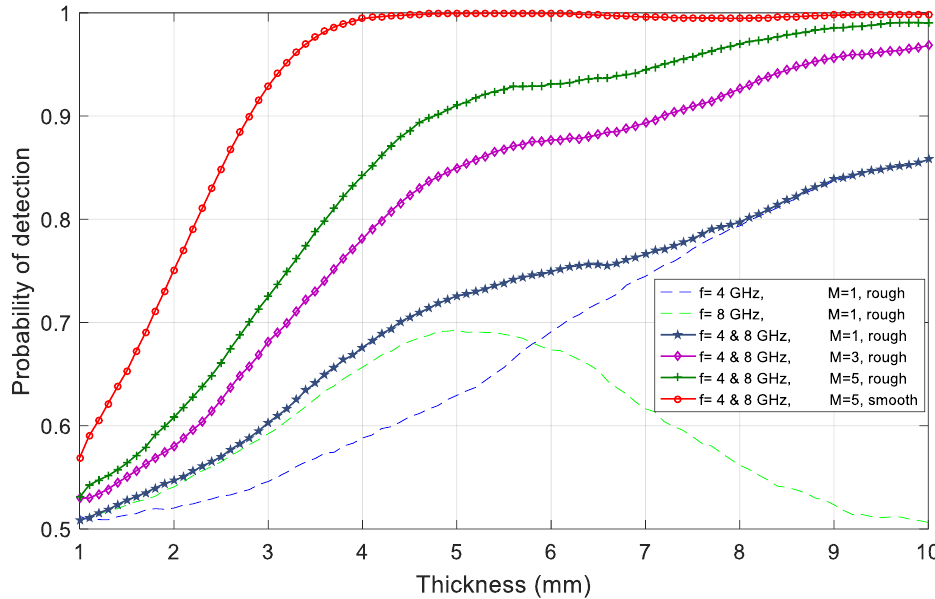
Figure 6. Comparison between the probability of detection versus the oil thickness (in mm) for different detector algorithms: single-frequency detectors at 4 GHz and 8 GHz, and dual-frequency detectors using combinations of these frequencies, for different surface-roughness scenarios.